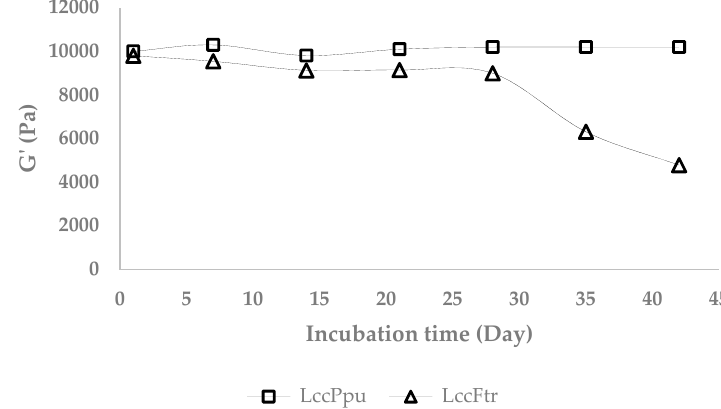
Figure 3. Storage modulus of the arabinoxylan (AX) gels (6%) during six weeks incubation at 25 °C. Gels formed using laccase Ppu showed a tan δ ≤ 0.5 after 28 days of storage. Although an increase